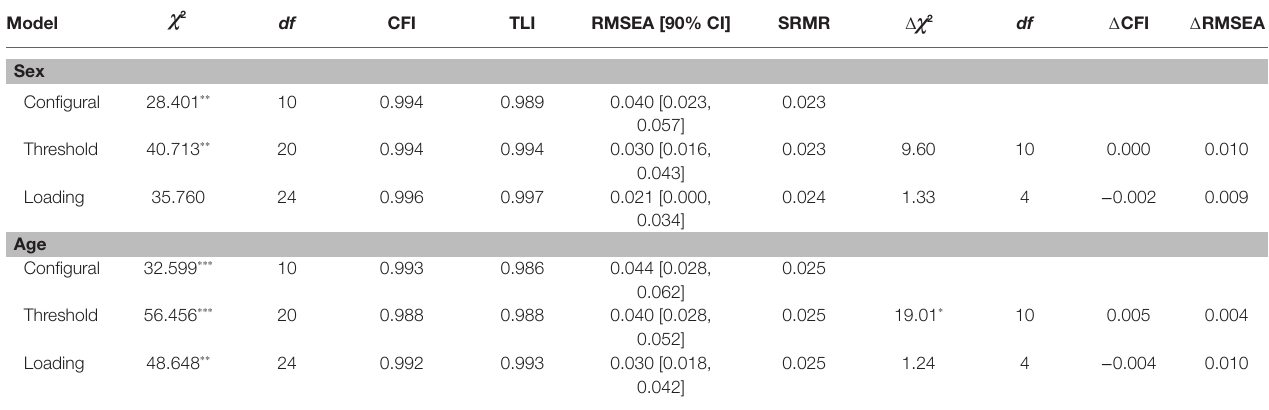
TABLE 3 | Model fit statistics for evaluating measurement invariance (MI) across sex and age. Model